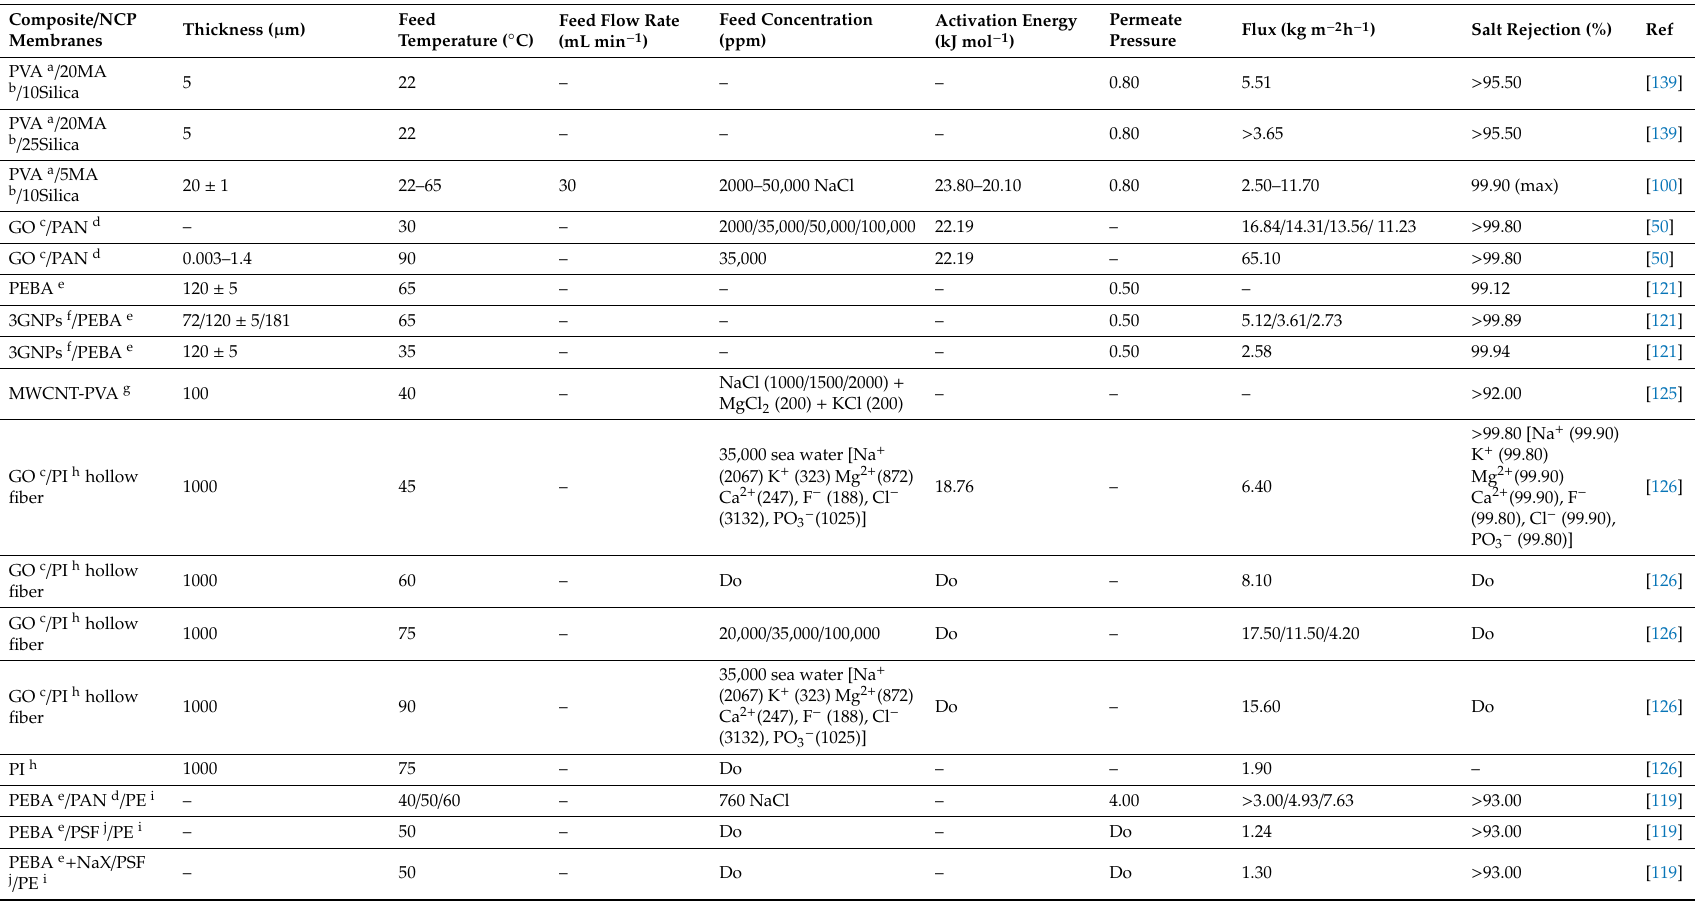
Table 3. Performances of polymeric membranes in pervaporative